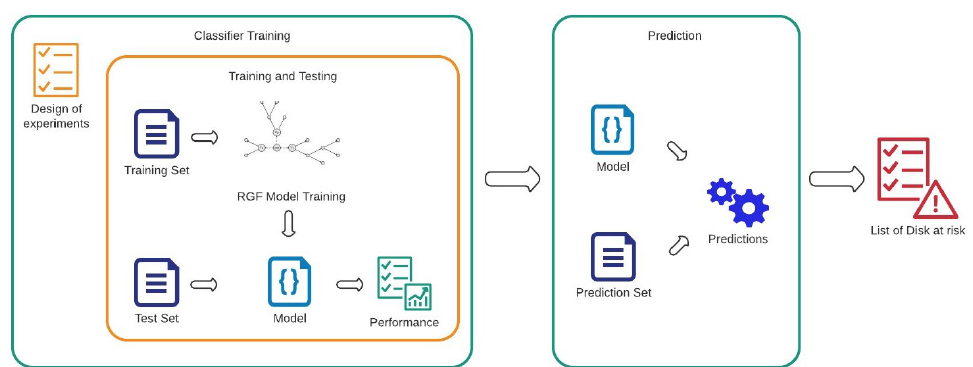
Figure 1. Data Collection and pre-processing phases.